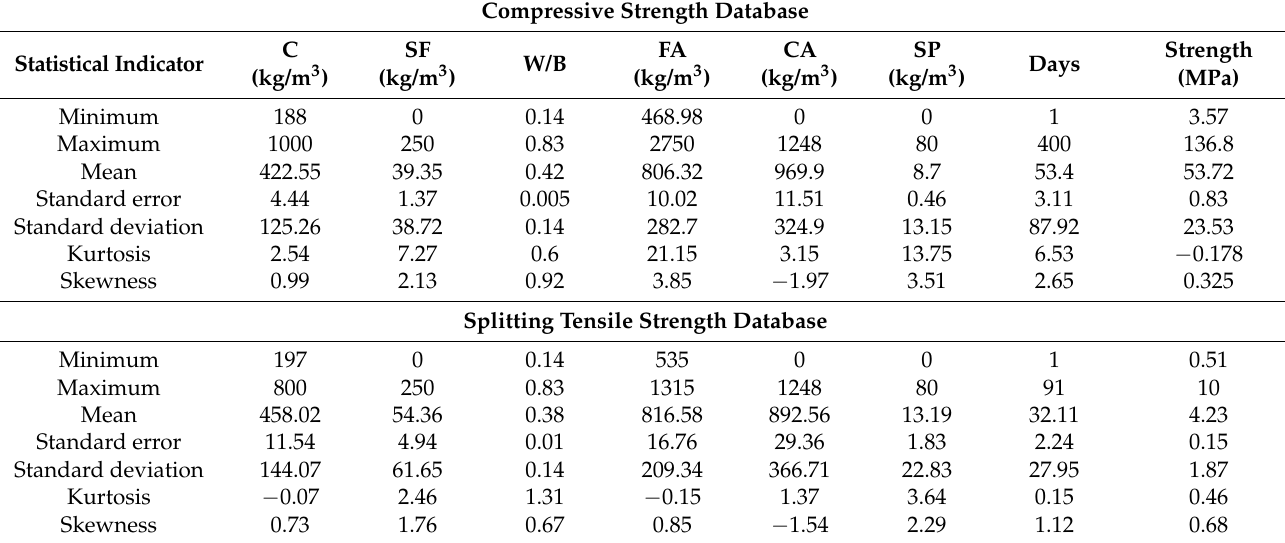
Table 1. Descriptive statistics of the database used in the training dataset.